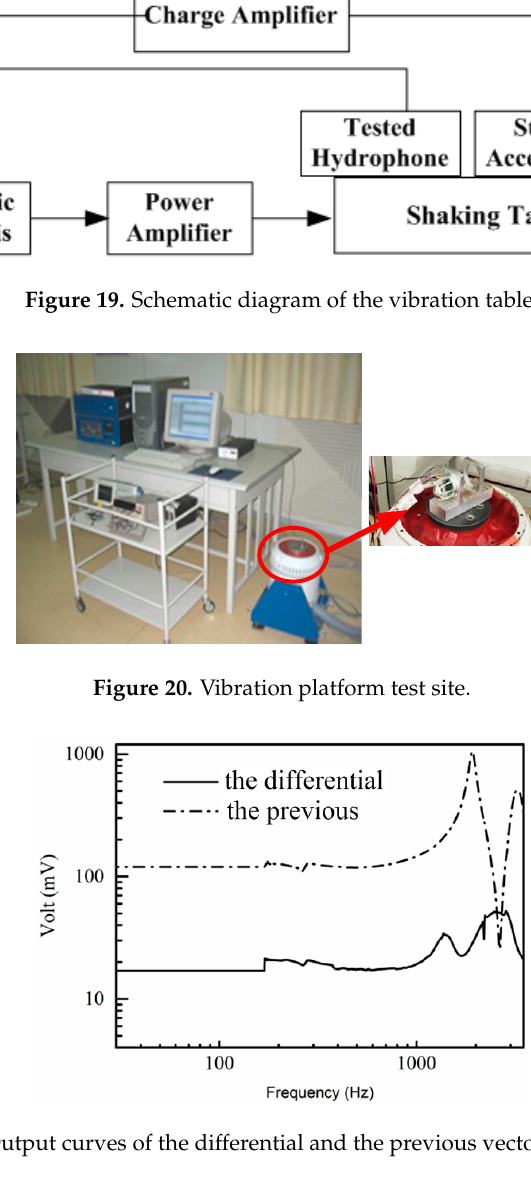
Figure 21. Output curves of the differential and the previous vector hydrophones.